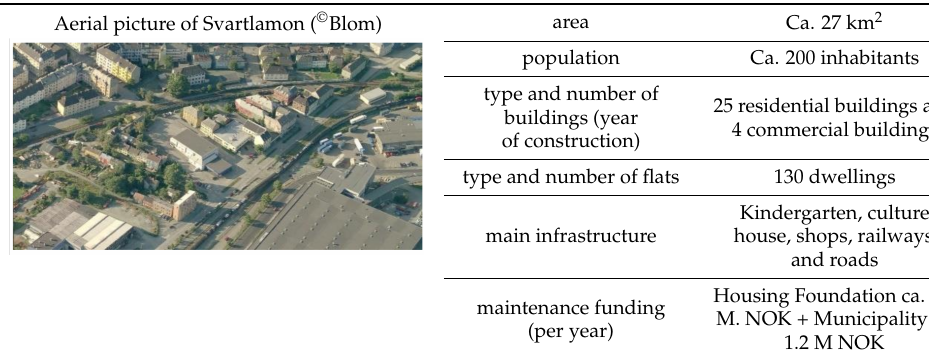
Table 1. Characteristics of